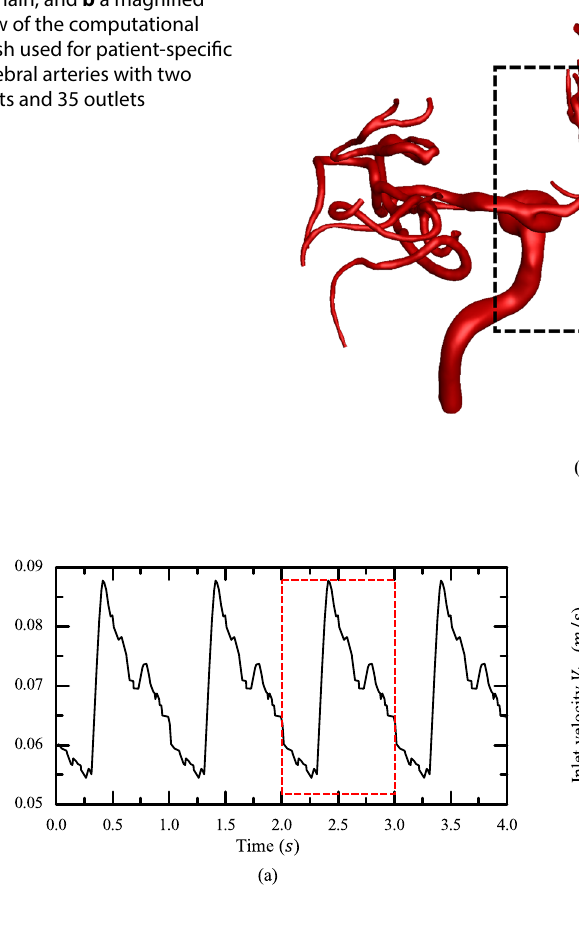
Fig. 11 a The computational domain, and b a magnified view of the computational mesh used for patient-specific cerebral arteries with two inlets and 35 outlets